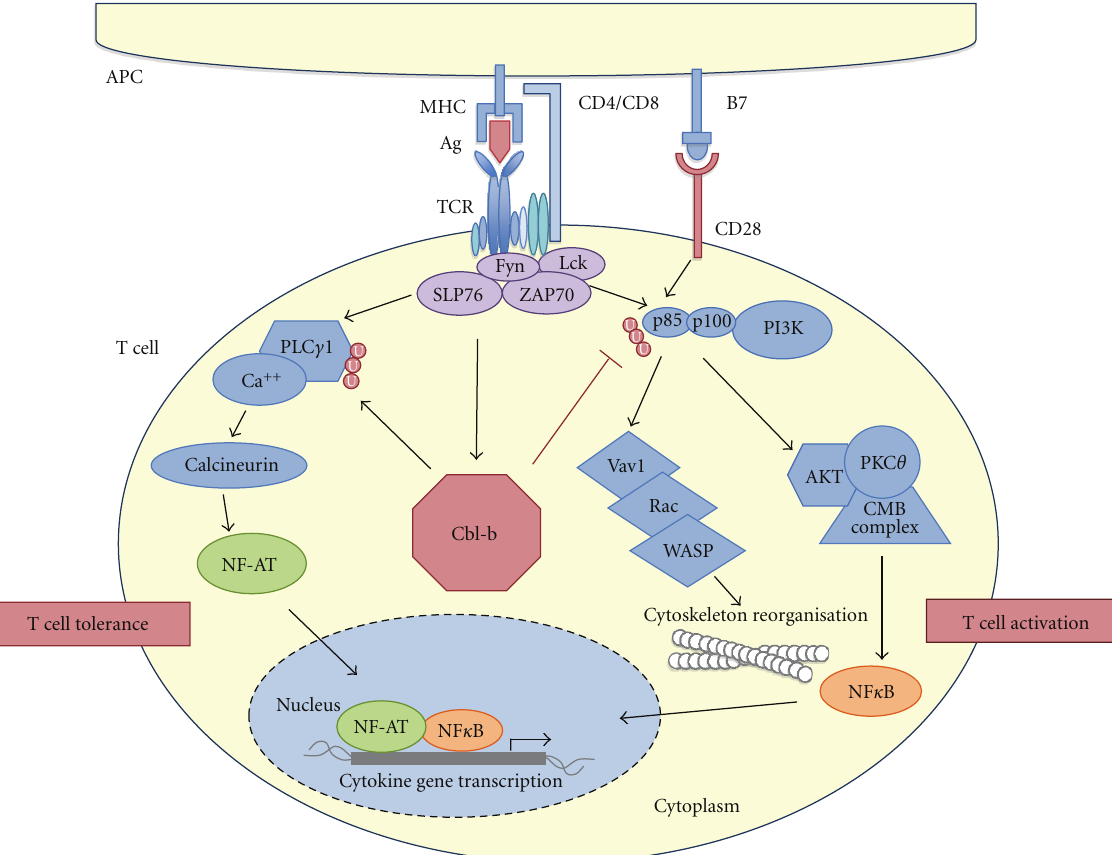
Figure 2: Cbl-b functions as central gate keeper of T-cell activation. T-cell stimulation via the TCR and the second costimulatory signal leads to the proximal activation of signaling pathway components. In the absence of costimulation, Cbl-b promotes antigen-specific T-cell tolerance. Thus, Cbl-b functions as negative regulator of the activation of T cells that can be, however, bypassed by CD28 stimulation. In the absence of Cbl-b, T cells are not dependent on a costimulatory signal and proliferative as well as cytokine response upon sole TCR- activation is comparable to WT T cell stimulated via the TCR and CD28. Note that the signaling cascades and interactions are simplified and do not show all molecules involved. For further details please refer to text. Flat-ended lines indicate inhibitory interactions. APC, antigen— presenting cell; U,